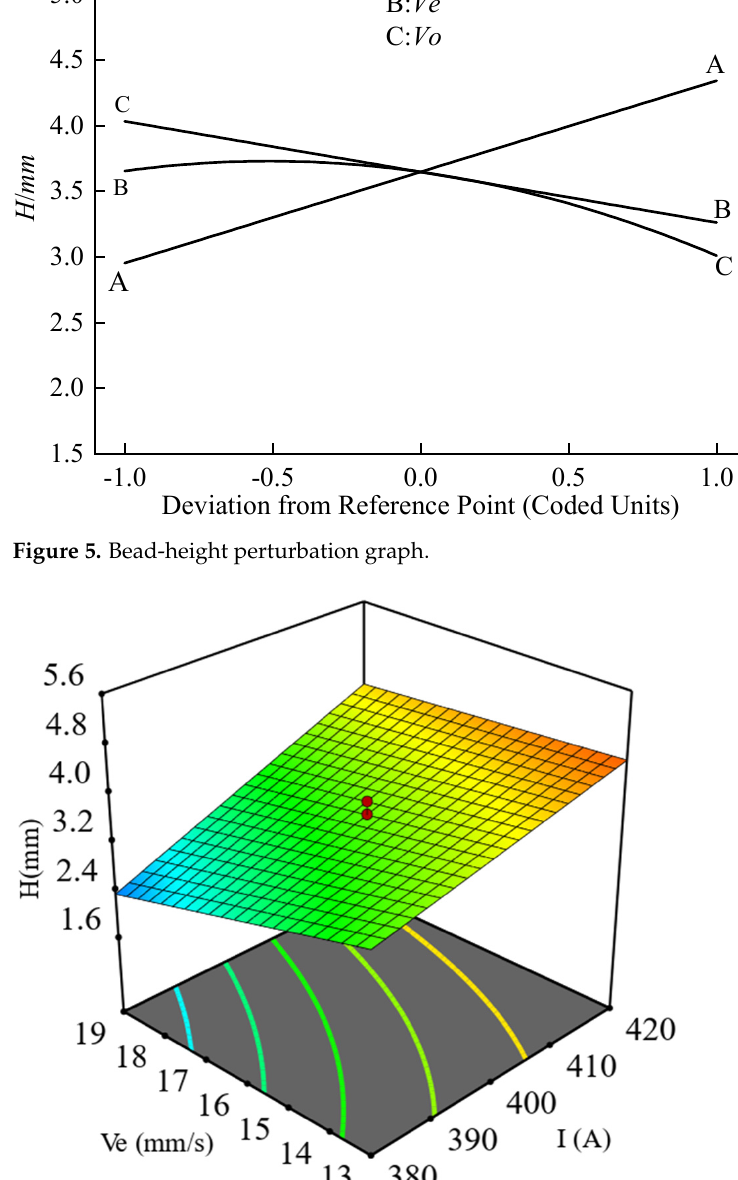
Figure 6. Combined effects of Ve and I(A) on dilution rate.